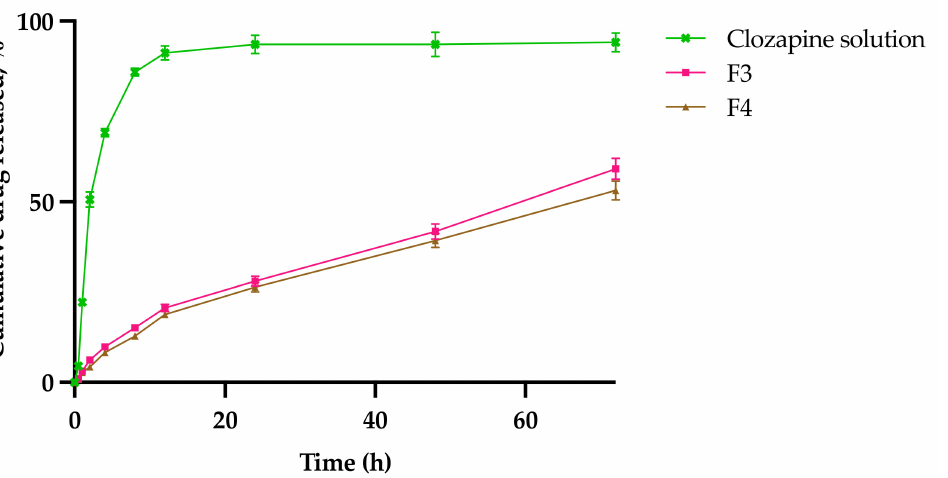
Figure 14. Cumulative percentage of clozapine released from clozapine solution, F3 and F4 gel matrix at 34 ◦ C.